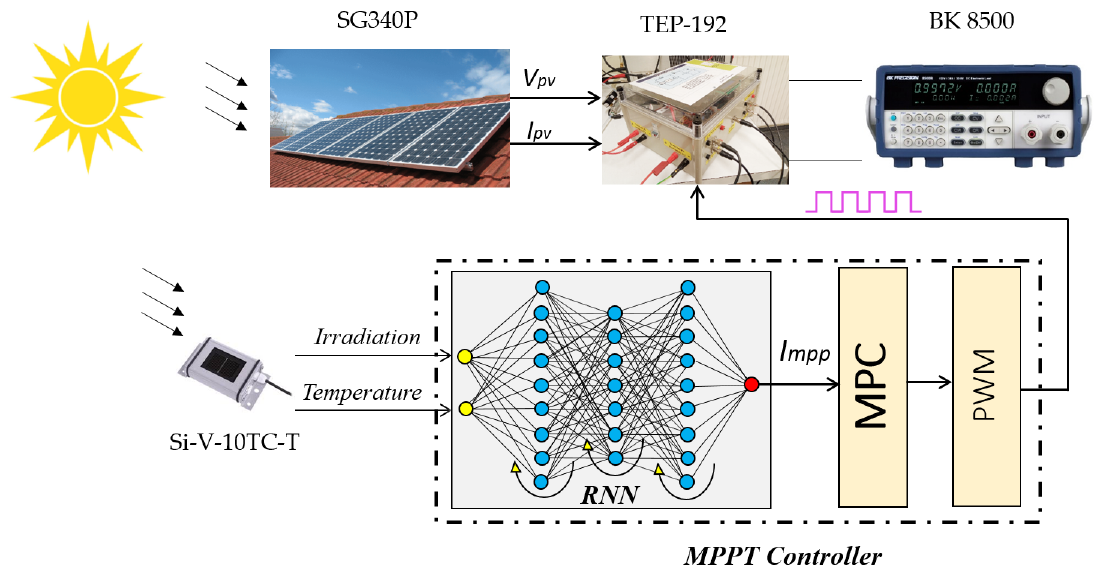
Figure 9. Implementation architecture of the MPPT